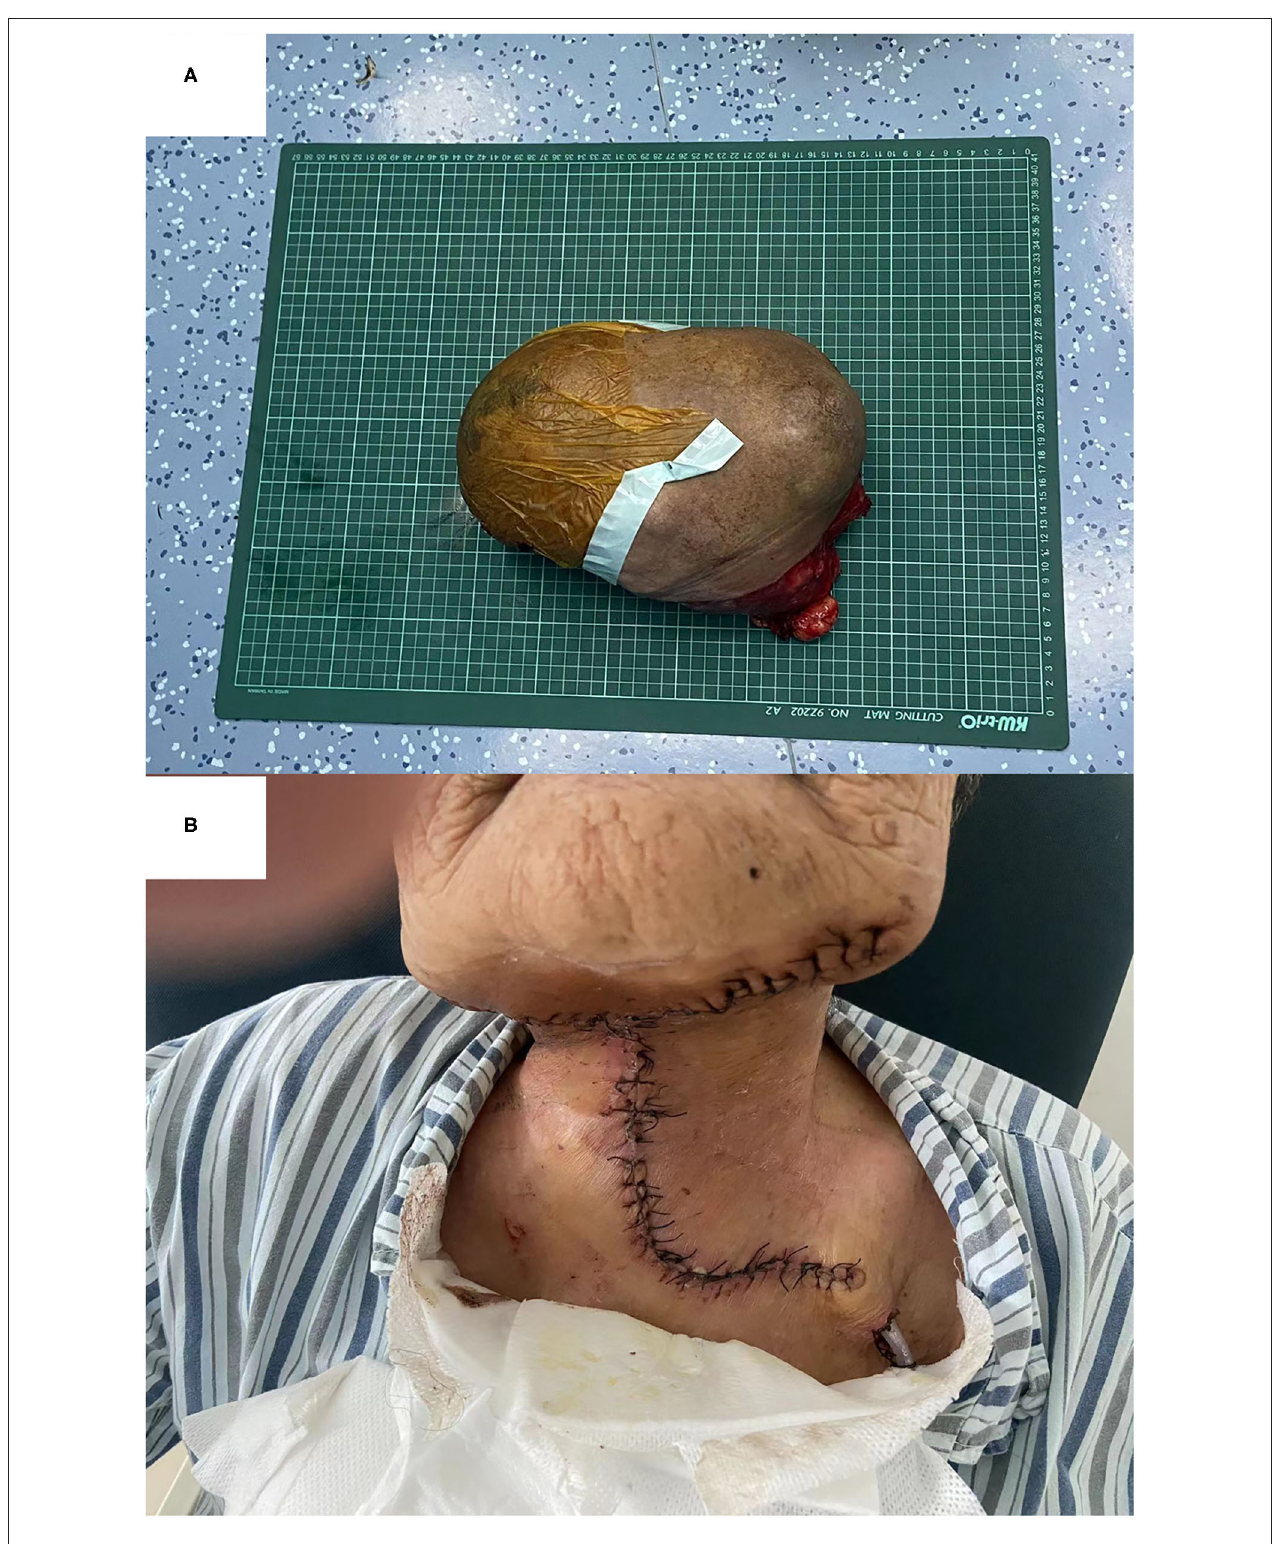
FIGURE 4 | Gross view of the resected specimen (A) and appearance of the incision on the neck (B) .